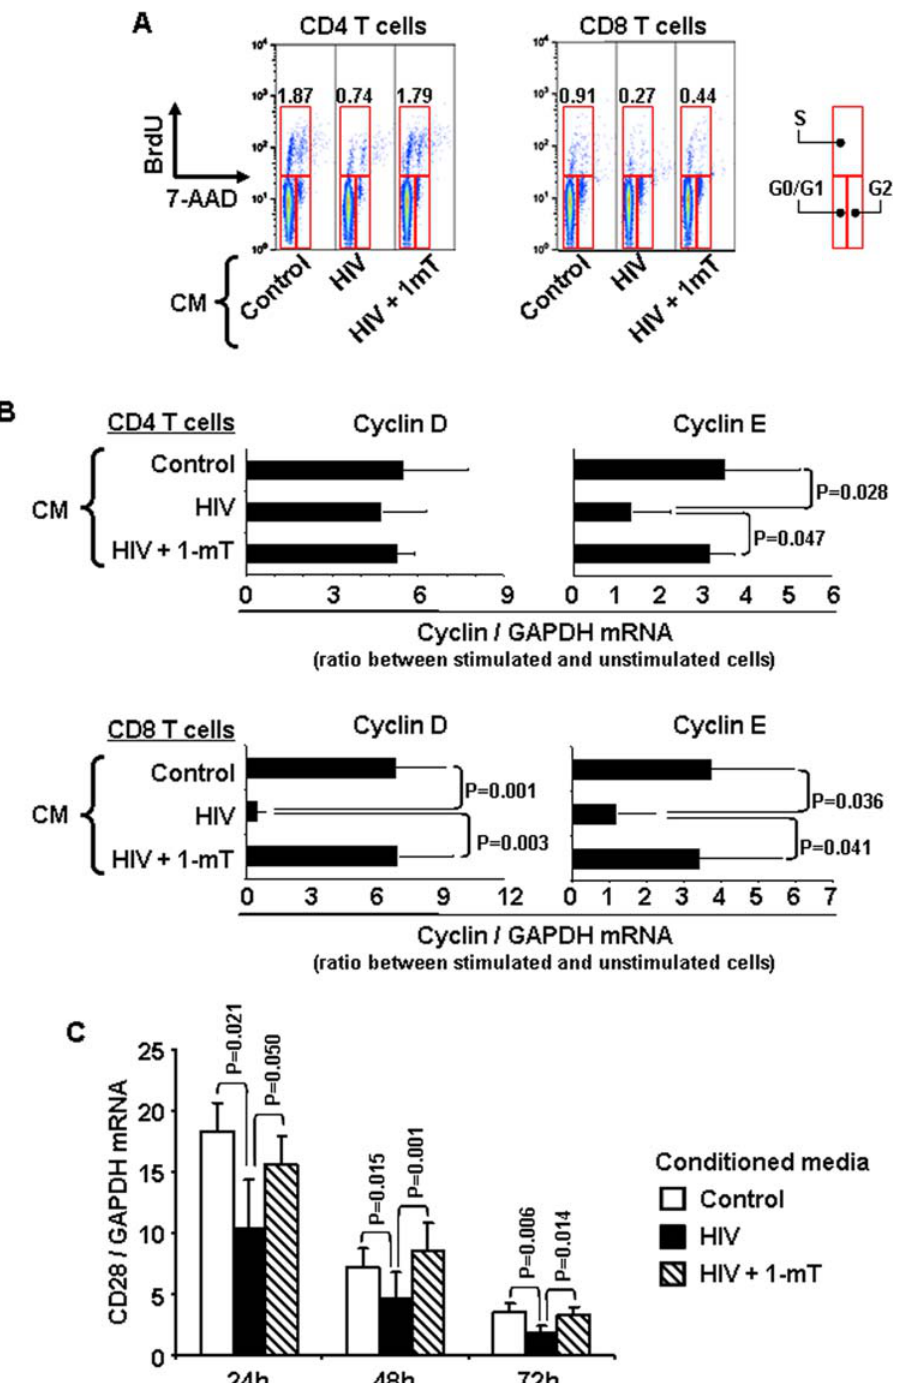
Figure 5. Effect of HIV-induced IDO on CD4 and CD8 T cell cycle progression in a 2-step experiment. ( A ) Flow cytometry dot plots showing BrdU incorporation and DNA staining with 7-AAD for one example experiment for CD4 and CD8 T cells stimulated with anti-CD3 and anti- CD28 in the three different conditioned media (CM); red boxes indicate gates for cells in G0/G1, S and G2 phase; numbers represent the percentage of T cells in S phase for each condition. ( B ) Cyclin D1 (marker of G1 phase) and cyclin E1 (marker of S phase) mRNA expression in CD4 and CD8 T cells stimulated in the three different conditioned media (CM). Relative mRNA levels are calculated as ratio between stimulated (with anti-CD3 and anti- CD28) and unstimulated cells. ( C ) CD28 mRNA expression in unstimulated CD8 T cells cultured in the three different conditioned media (CM) over a 72 hours period. In all bar graphs mean values 6 standard error calculated on 8 independent experiments are shown.